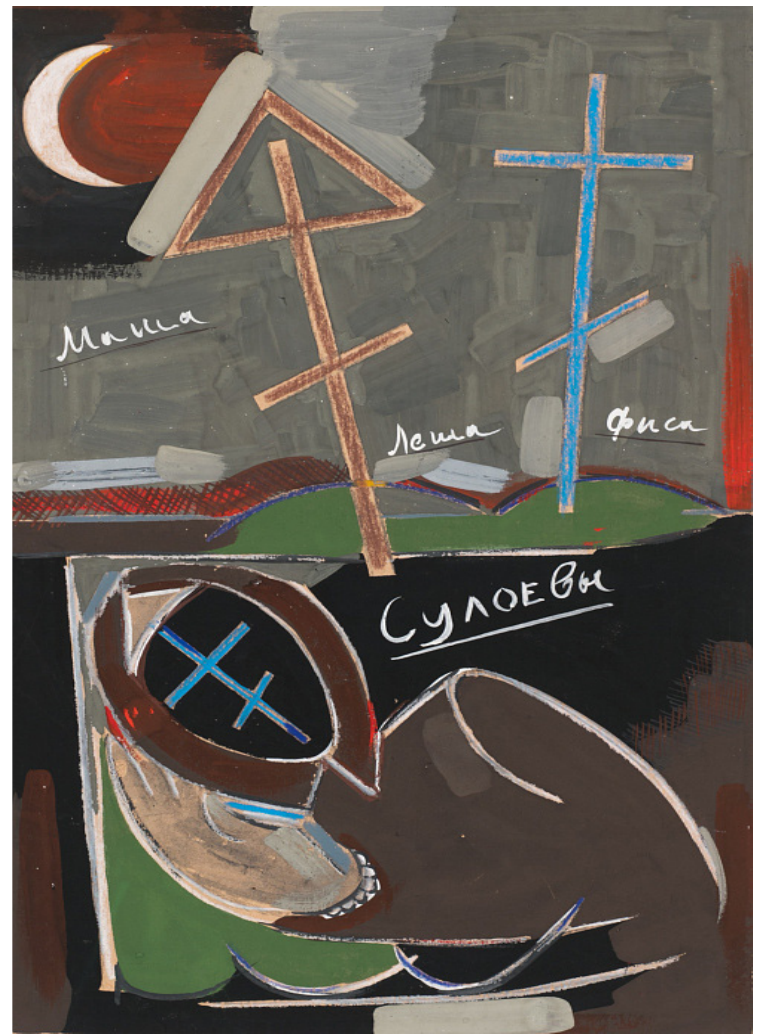
Figure 8. Eduard Steinberg. Masha, Lyosha and Fisa Suloyevy. 1980s. Cardboard, gouache, pastel. 60 * 39. Art4 Museum, Moscow https://www.art4.ru/museum/shteynberg-eduard/ (accessed on 12 June 2022).